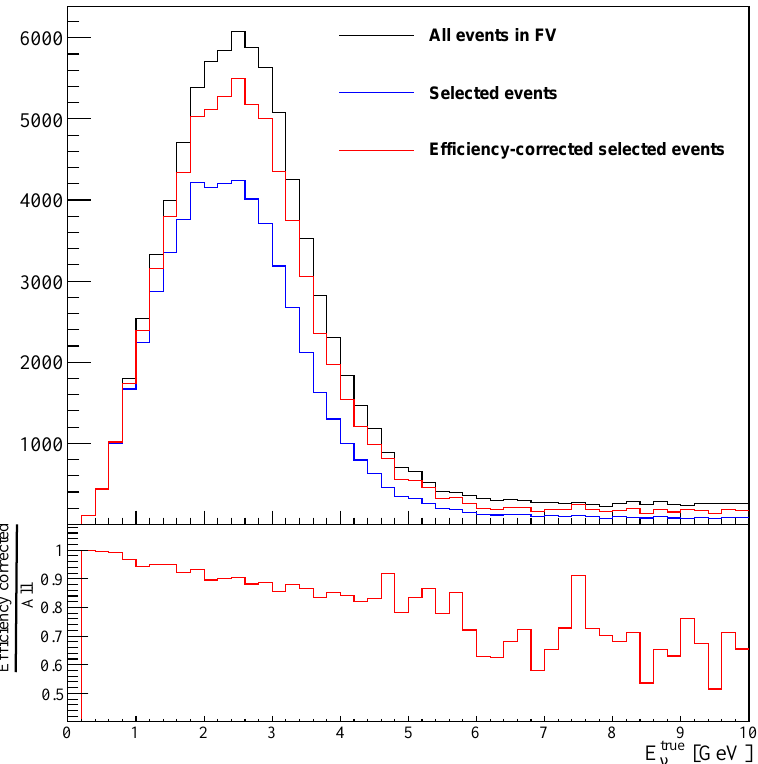
Figure 113. The true neutrino energy distribution is shown for all interactions within the ND fiducial volume, events that pass the selection criteria, and selected events with the event-by-event geometric efficiency correction